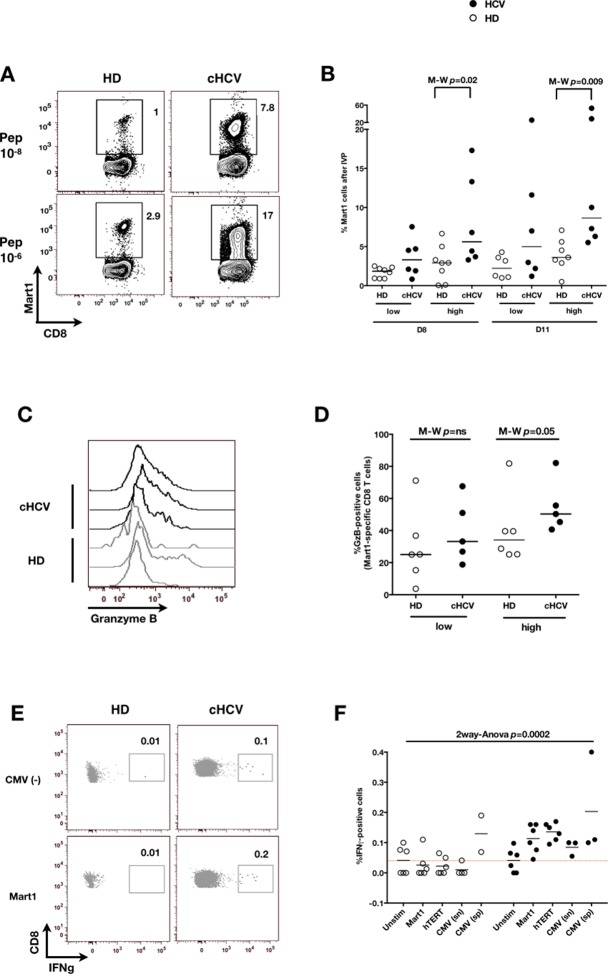
Memory phenotype cells can be expanded to generate robust CD8+ T cell responses.(A) Examples of Mart1-specific populations expanded from HD and cHCV patients after 8 days of in vitro priming (IVP) with low (10–8, upper line) and high (10–6, bottom line) doses of Mart1 peptide. FACS plots from all donor tested are provided in Figure 6—figure supplement 1. (B) Percentages of Mart1-specific cells expanded after 8 and 11 days of IVP with low and high doses of Mart1 peptide as in A. Proportions of MP cells within those expanded populations are indicated in Figure 6—figure supplement 2. (C) Representative histograms of intracellular granzyme-B expression by Mart1-specific T cells expanded from 3 HD and 3 cHCV after 8 days of IVP with high doses of peptide as in A. (D) Percentages of granzyme-B-expressing Mart1-specific T cells expanded from HD and cHCV patients after 8 days of IVP with low and high doses of Mart1 peptide. Baseline percentages are indicated in Figure 6—figure supplement 3. (E) Representative examples of IFNγ detection intracellularly after in vitro restimulation with CMV or Mart1 peptides in CMV seronegative, tumor-free HD and HCV patients. IFNγ-positive populations are overlaid on total CD8+ T cells. (F) Percentages of cells with IFNγ-positive staining after Mart1-, hTERT-, and CMV- in vitrorestimulation in HD and cHCV patients. sn, seronegative; sp, seropositive.